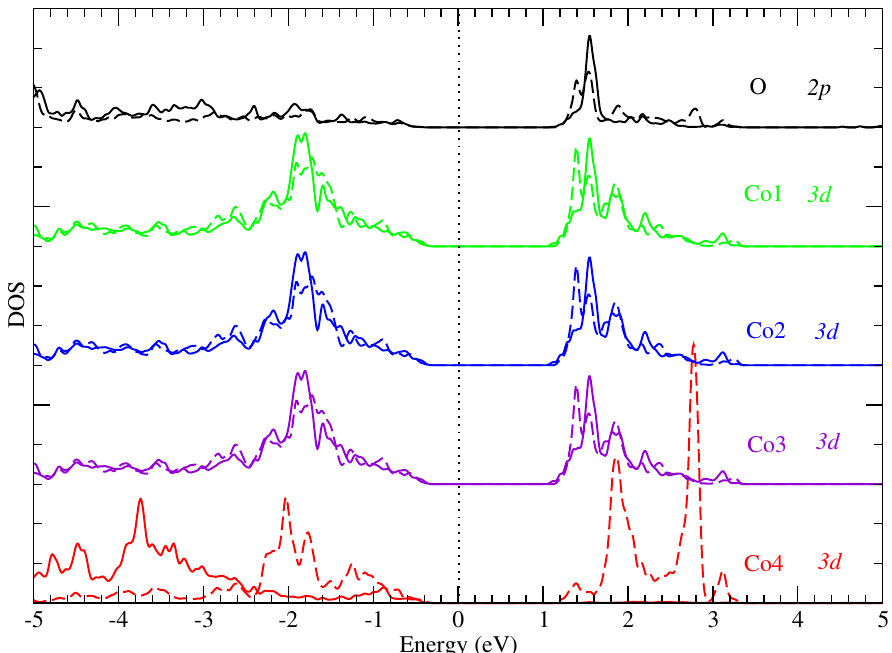
Figure 4. Partial DOS, for the 2 p orbital of the absorbing oxygen atom and 3 d orbitals of the nearest cobalt atoms Co1, Co2, Co3 and Co4. Solid and dashed lines correspond to spin-up and spin-down DOS components,